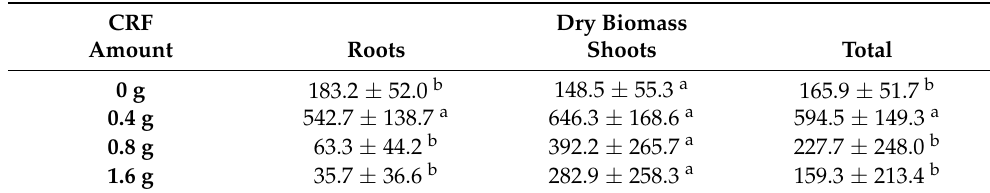
Table 5. Effect of different concentration of CRF on dry biomass of roots, shoots, and entire plantlets (total).